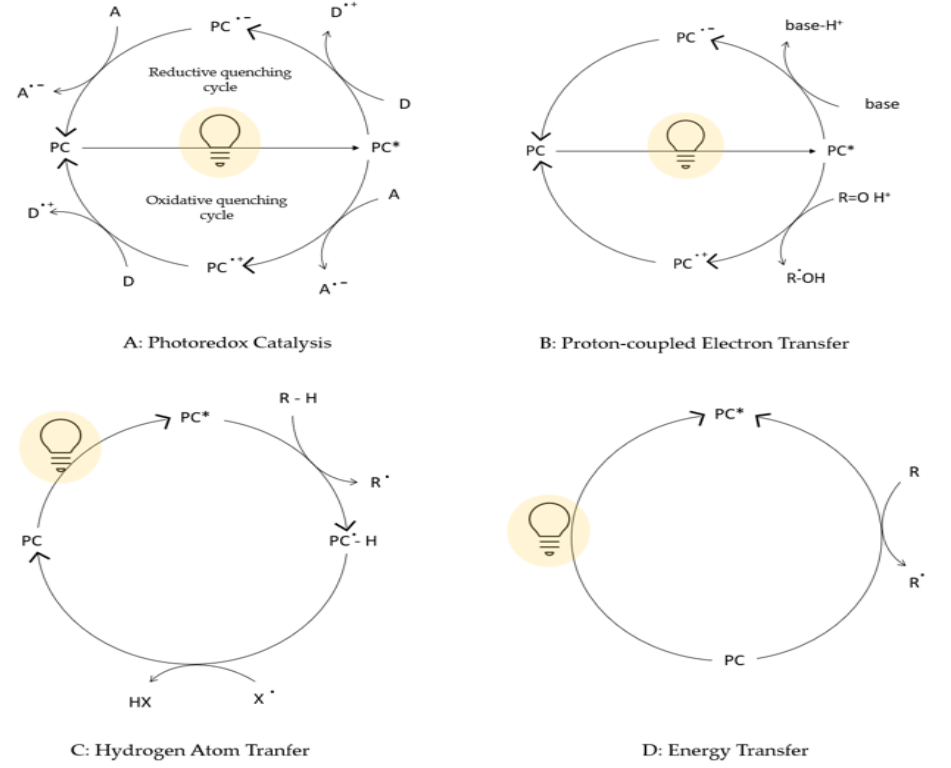
Figure 1. General mechanistic scenarios in photocatalytic synthesis. In all the pathways reported, the first step concerns the formation of an excited photocatalyst upon irradiation (PC*). ( A ) Photoredox Catalysis: PC* accepts or donate a single electron leading to oxidative or reductive quenching cycles depending on the substrates present in the reaction mixture (presence of electron acceptor or donor); ( B ) Proton-coupled Electron Transfer: redox events occur during a concerted proton transfer; ( C ) Hydrogen Atom Transfer: homolytic cleavage of C–H bonds by the photocatalyst or after singlet electron transfer events; ( D ) Energy Transfer: PC directly transfers its excited state energy to a substrate that normally is not able to absorb light (at the given wavelength) leading to a chemical reaction. Reprinted with permission from ref. [1]. Copyright 2021 iScience.